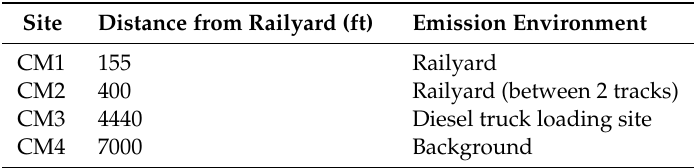
Table 1. Location of collection sites at